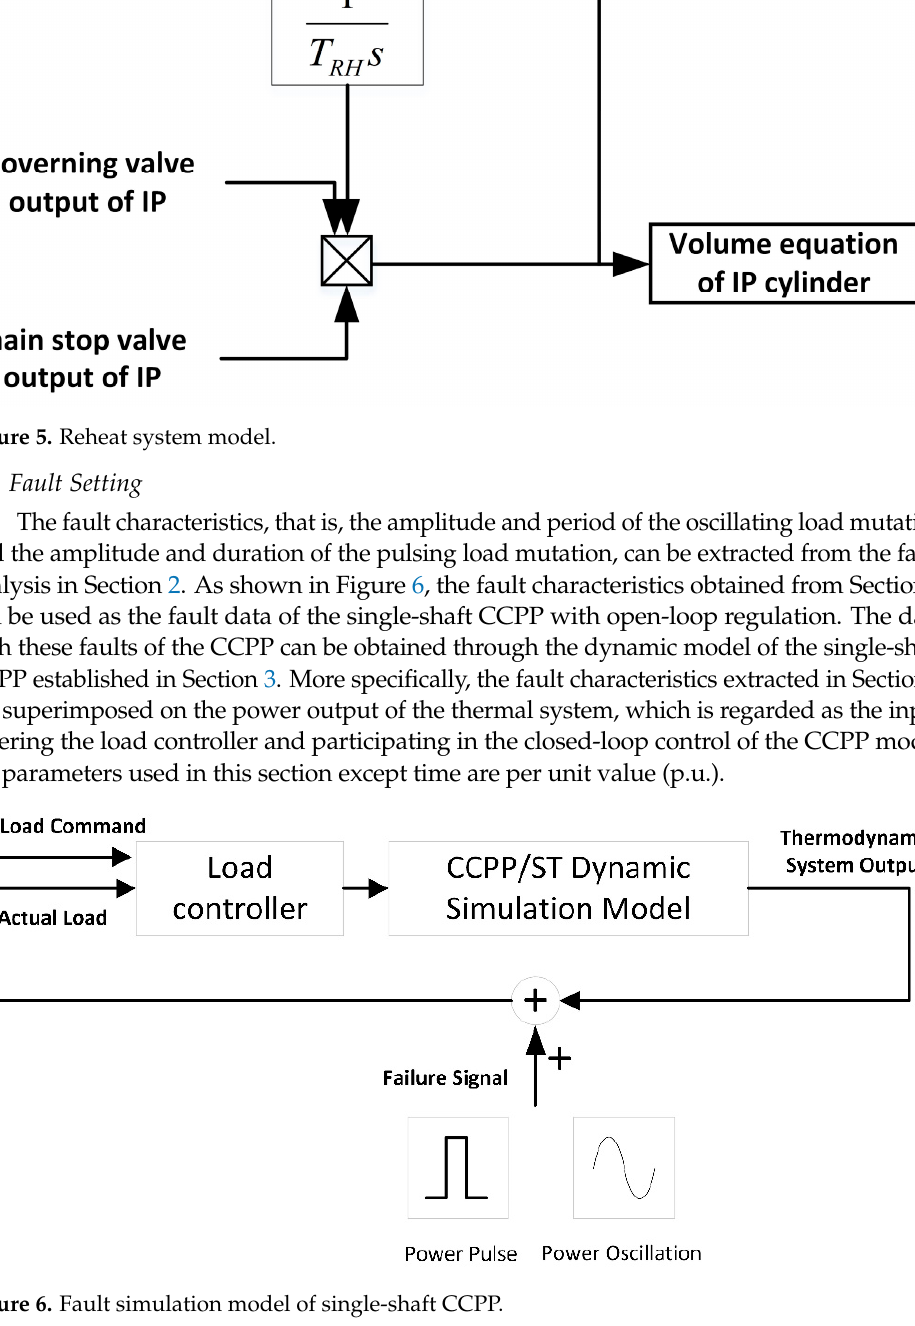
Figure 4. Nozzle Volume Model.